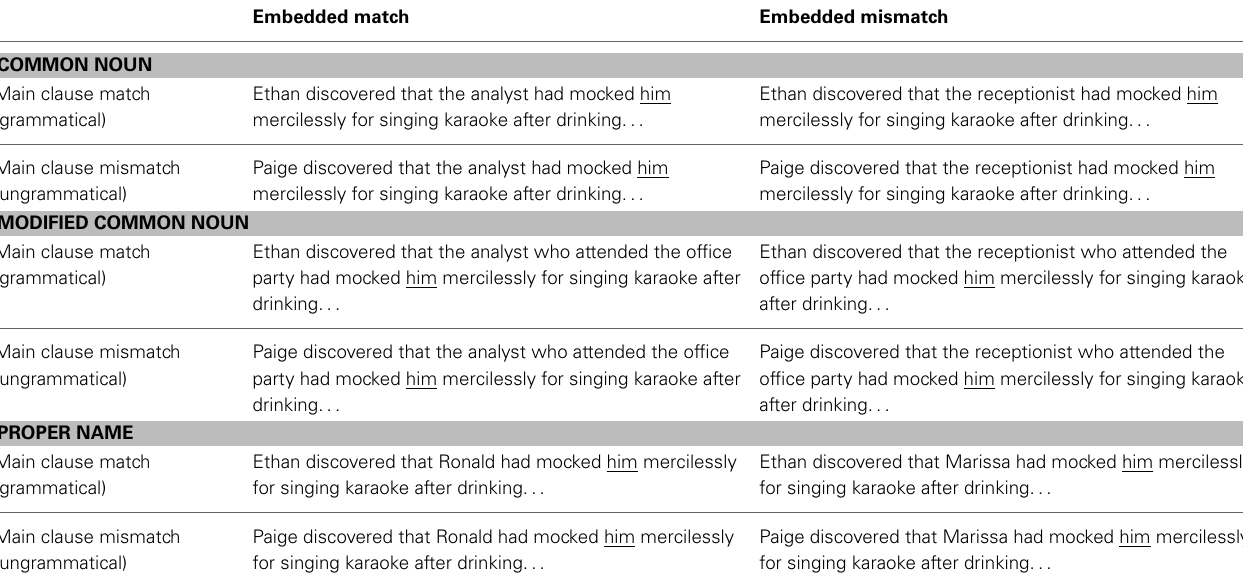
Table 1 | Experimental conditions and sample materials in Experiment